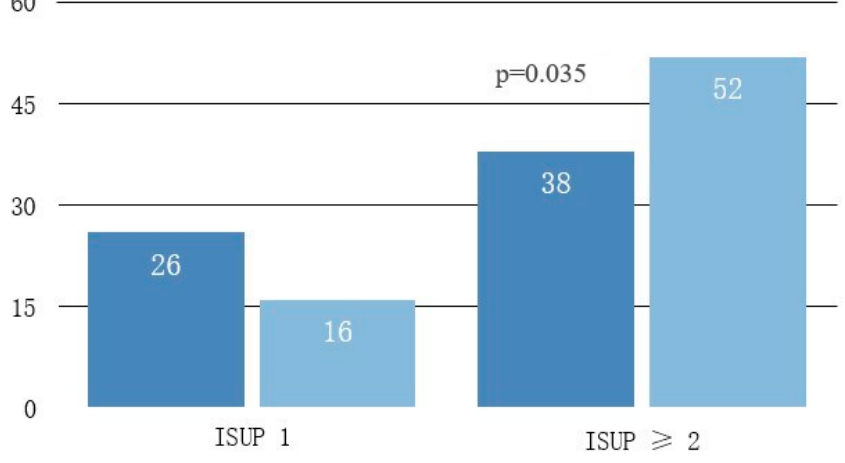
Figure 2. Pathology ISUP score significant increase by using CF vs. SB led to the diagnosis of more clinically significant cancer and upgraded patient prognostic group. CF = cognitive fusion biopsy, SB = systematic biopsy.